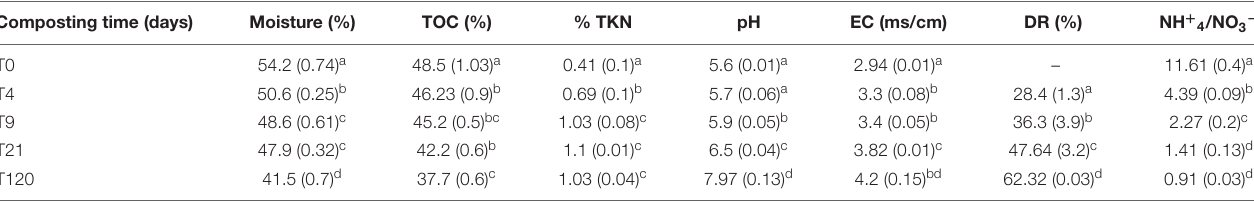
TABLE 2 | Physicochemical characteristics of the compost at T0 = initial mixture and after 4 days (T4), 9 days (T9), 21 days (T21), and 120 days (T120). Composting time